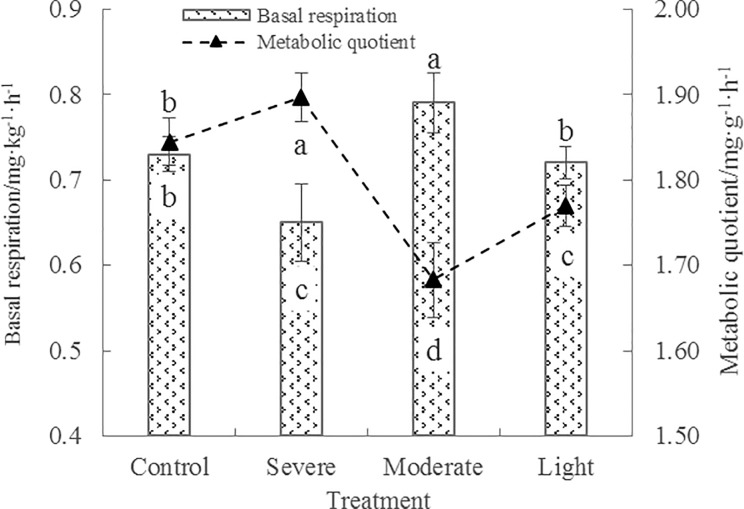
Effects of root pruning on basal respiration and metabolic quotient in the rhizosphere soil of poplar.Bars are means, and error bars are standard deviations (n = 3). Different letters indicate significant differences among treatments at P<0.05 by LSD.